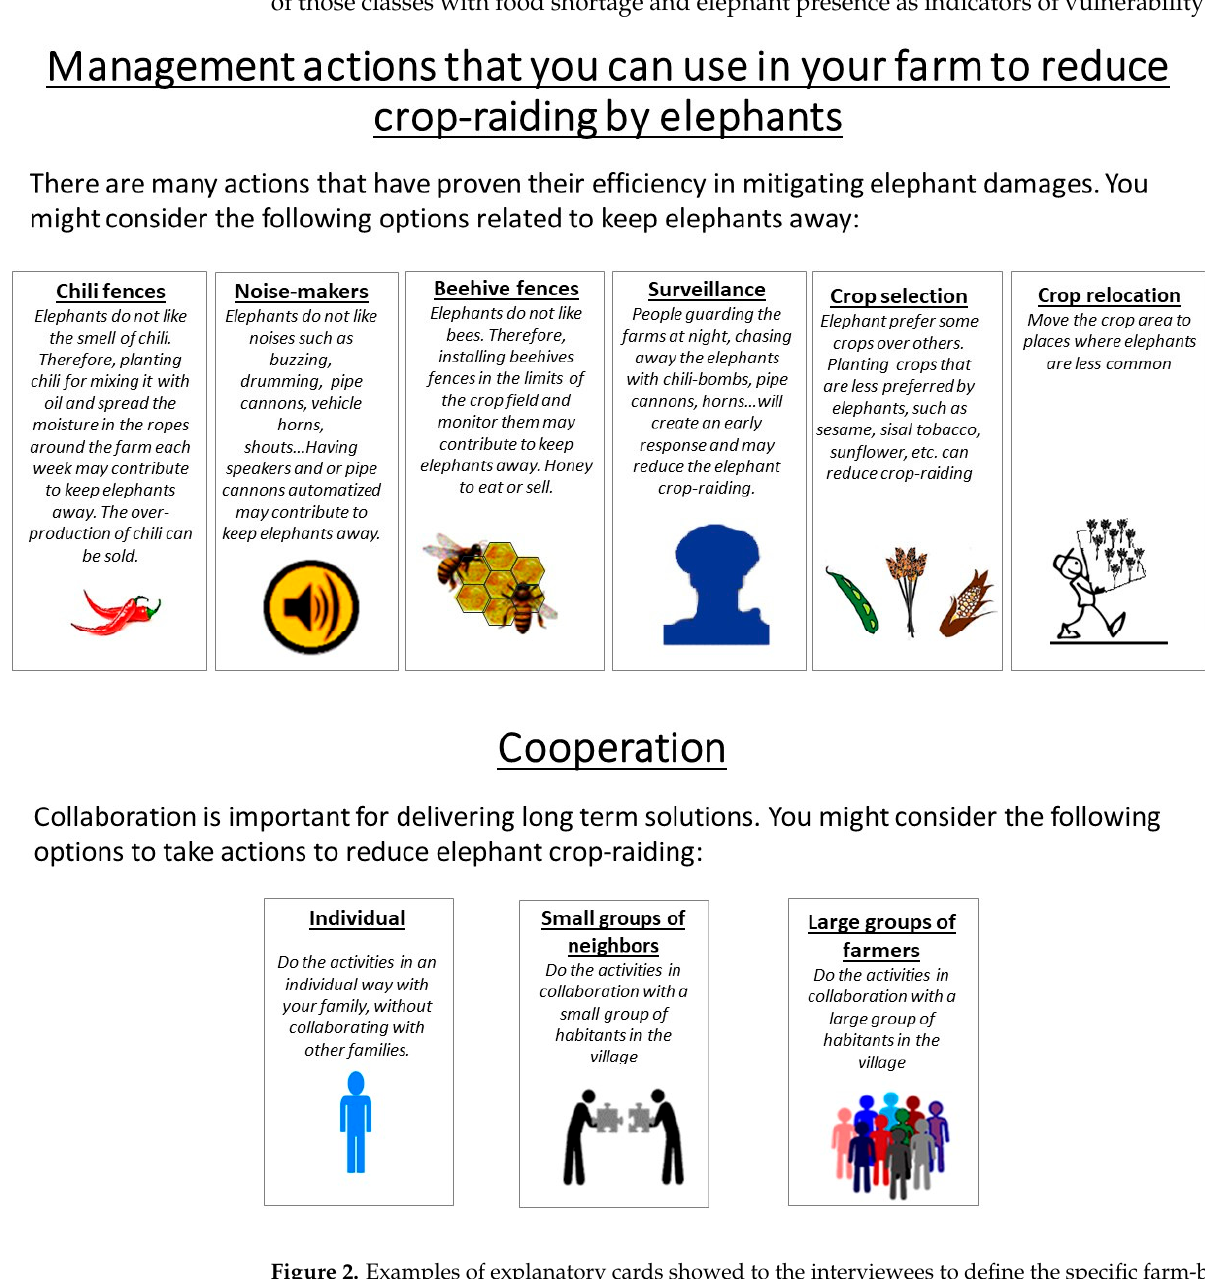
Figure 2. Examples of explanatory cards showed to the interviewees to define the specific farm-based measures that farmers can apply to reduce elephant damage and the level of cooperation in the implementation of those measures.